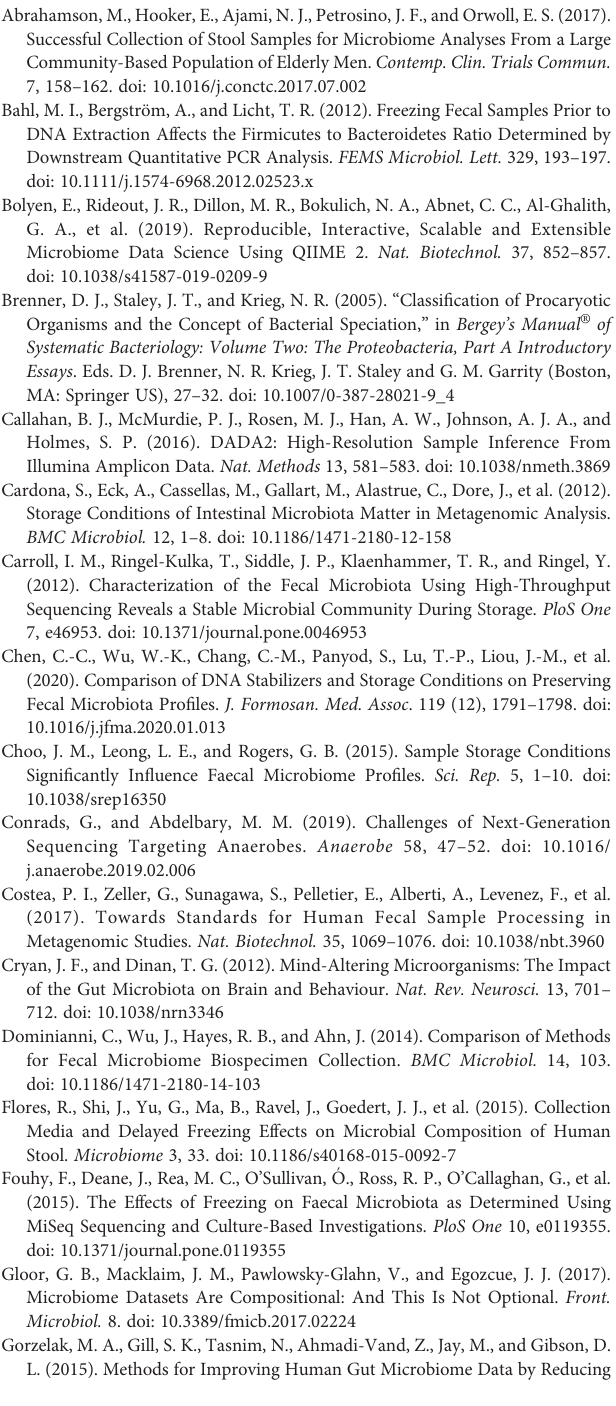
Supplementary Figure 7 | Differentially abundant bacterial genera among samples and their references among 10 tested DNA stabilizing solutions. The median log2-fold change between average pro fi les and signi fi cance of the corresponding paired Wilcoxon test are shown. (*) indicates fdr<0.05, (**) indicates fdr<0.01, (***) indicates fdr<0.001.